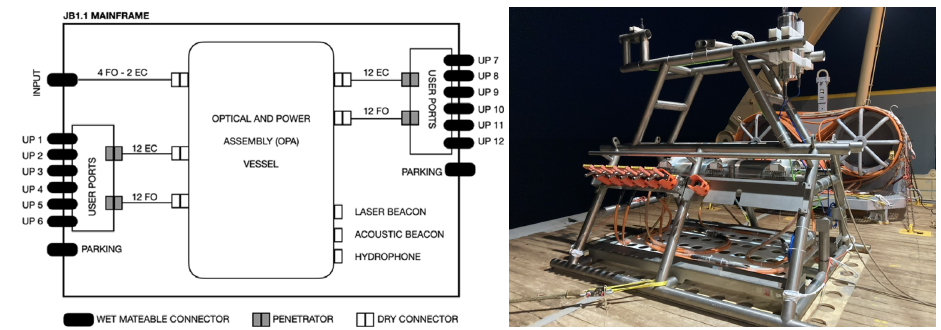
Figure 2. Left: The block diagram of the ARCA Junction Box. A titanium mainframe hosts all the instrumentation and connectors. To improve reliability, the number of connections in water is min- imised. The sub-systems, the control and power electronics plus the optical circuits are fully contained in a unique cylinder with a volume of about 100 litres. Right: A JB ready for deployment during a sea campaign. The ROV mateable connectors (in orange) are visible in the front panel; they provide input and output connectivity